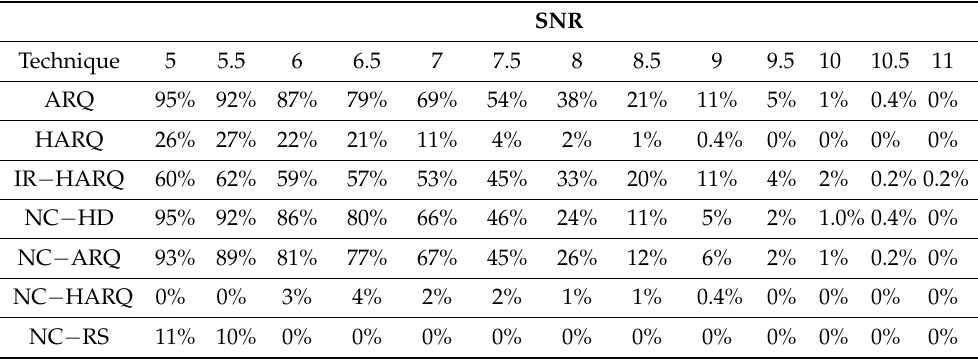
Table 4. AC2NC relative time saving gain—four